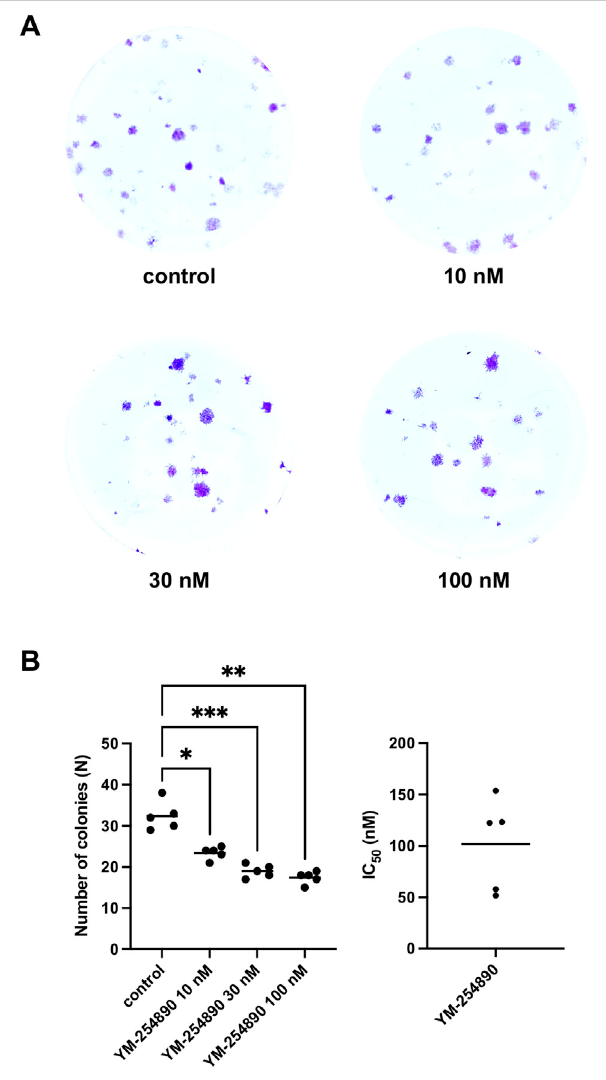
FIGURE 8 | Inhibition of prostate stromal WPMY-1 cell colony formation by YM-254890. Shown is the absolute number of colonies (N) after 168 h (means)asscatterplotscontainingdataofeachindividualexperimentfrom n = 5 independent experiments. The cells were either allocated to a YM- 254890 (10, 30, and 100 nM) or control group, with equal amount of solvent (DMSO, 10 μ l/ml). Cells were subsequently incubated for an additional 168 h. Shown are exemplary images of colony formation after 168 h (A) , and quanti fi cation of all experiments (B) with corresponding IC50 values from all fi ve experiments (right) (* p < 0.05, ** p < 0.01, *** p <